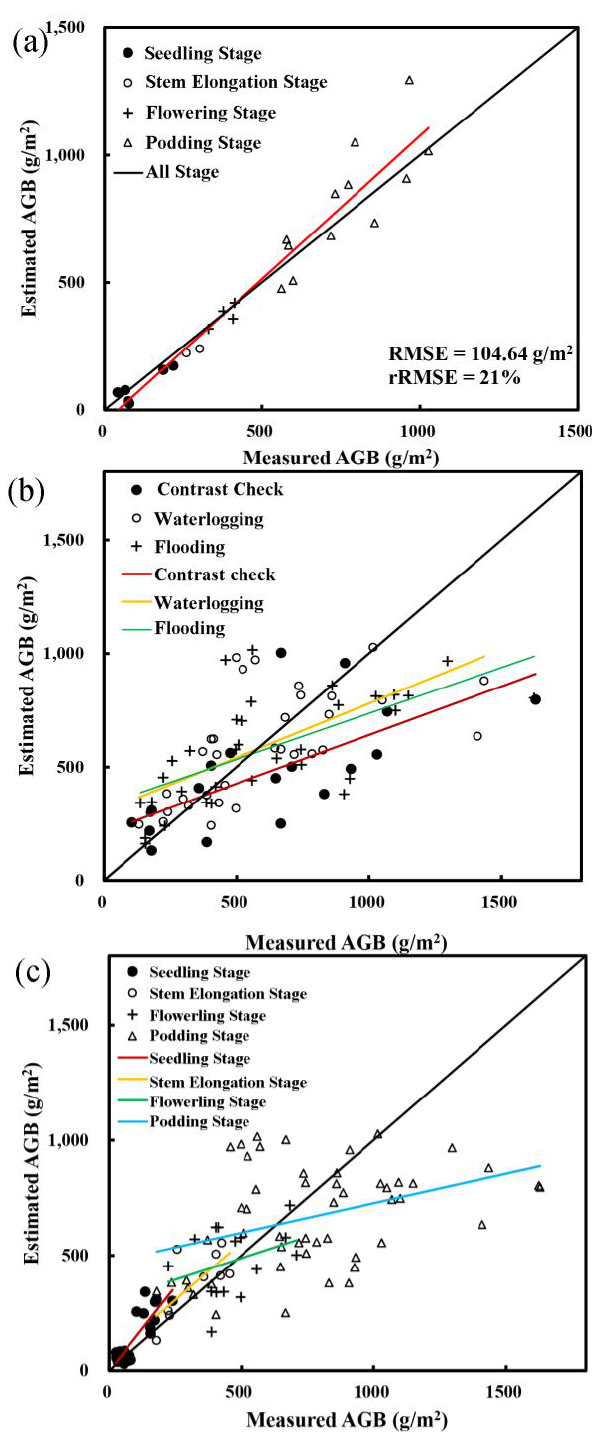
Figure 3. Comparison between measured AGB and estimated AGB. The black dash line is the 1:1 line and the colorized solid lines are the linear regression trend lines. The data set we used were: ( a ) the validation set; ( b ) the data collected from the plots conducting, or had finished with, the soil water content stress treatments; ( c ) the data collected from different growth stages.